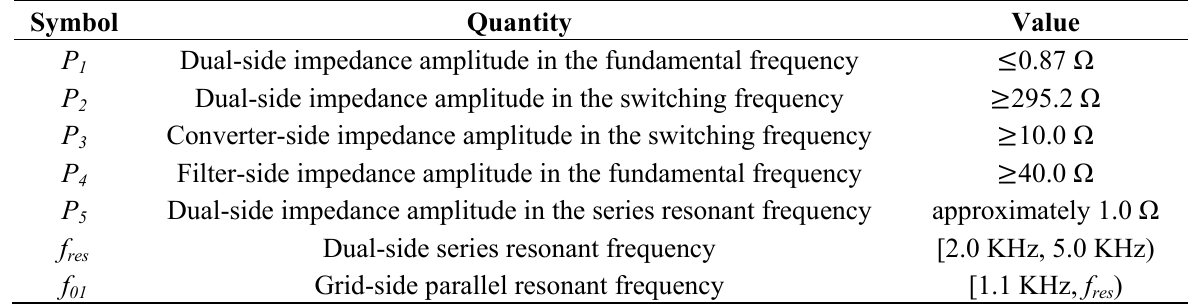
Table 2. Table of performance requirements in phases A, B, C, and N.